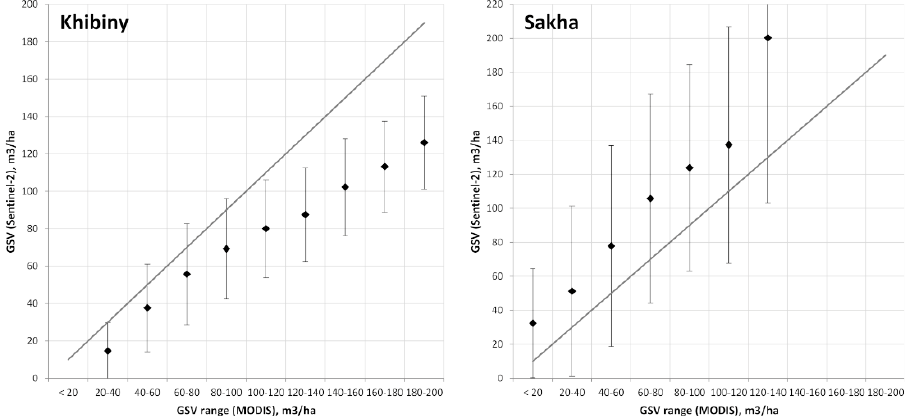
Figure 10. GSV estimates for forest areas in the two test sites corresponding to GSV ranges in the IKI MODIS product. Error bars show one standard deviation